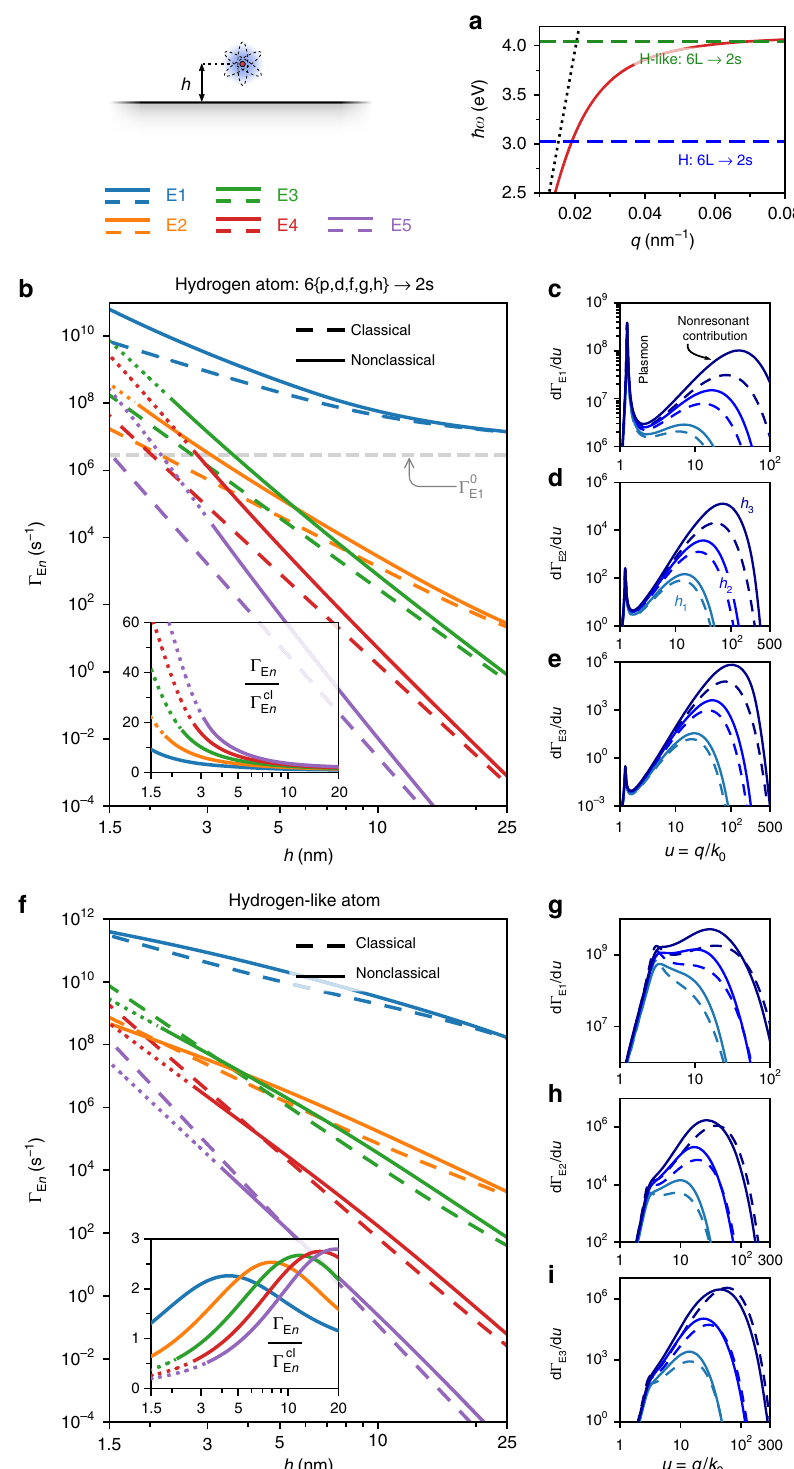
Fig. 4 Enhancement of dipole-forbidden electric multipole transitions. a Transition frequencies considered in b – e (dashed blue) and f – i (dashed green) relative to the plasmon (red) and light-line (dotted black) dispersion. b Multipolar transition rates, Γ E n , associated with the 6{p, d, f, g, h} ! 2s series of transitions in hydrogen ( _ ω 0 ¼ 3 : 02 eV). The dashed gray horizontal line marks the free-space E1 rate. The inset shows the relative rates, Γ E n = Γ cl Differential rates d Γ E n = d u [integrand of Eq. (8)] for various atom – surface separations: h 1 ¼ 10nm, h 2 ¼ 5nm, and h 3 ¼ 2 : 5nm. f – i Equivalents of b – e but at ffiffiffi p = the transition frequency ω 0 : 97 ω 2 . Dotted lines indicate regions where our nonclassical framework is pushed beyond its range of validity 0 ¼ p (identi fi ed heuristically as cases where contributions to Γ E n from q th Re d 1 = 3 exceeds ? (cid:9)